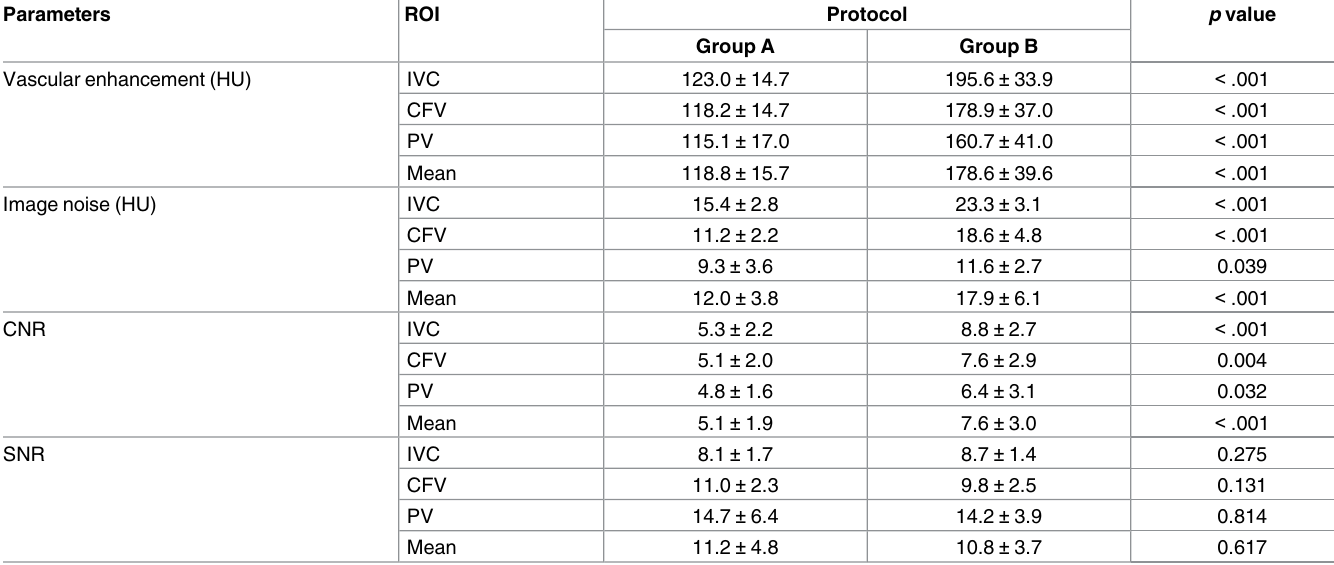
Table 2. Results of the objective analysis of two different CTV protocols. Parameters